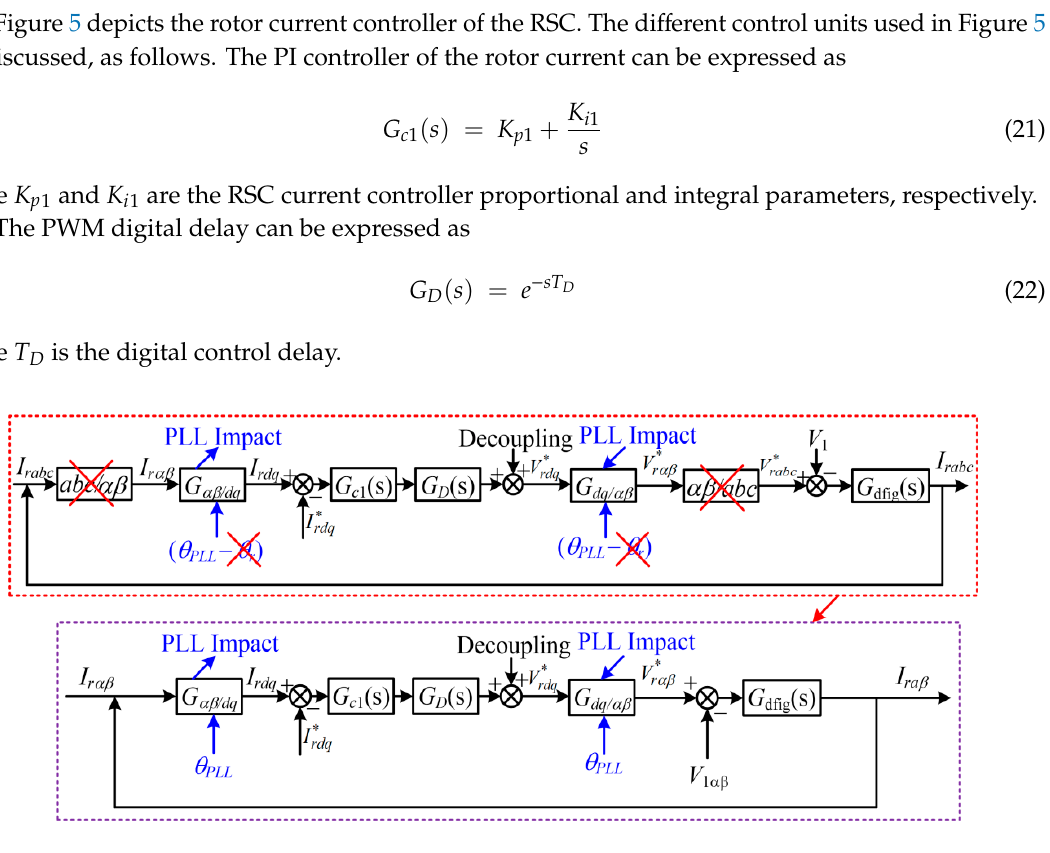
Figure 5. Schematic diagram of rotor side converter (RSC) rotor current control.